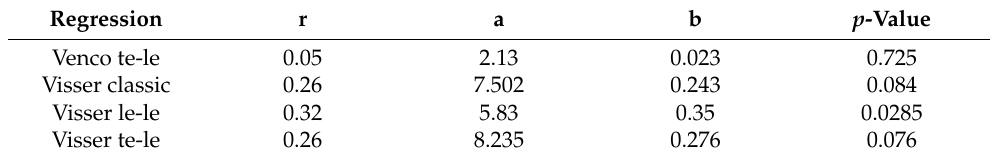
Table 4. Outcomes of Differences against means by linear regression analysis for proportional bias.